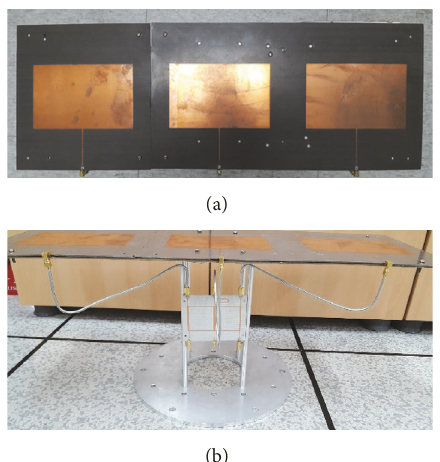
Figure 6: Fabricated beamwidth reconfigurable antenna: (a) top and (b) side